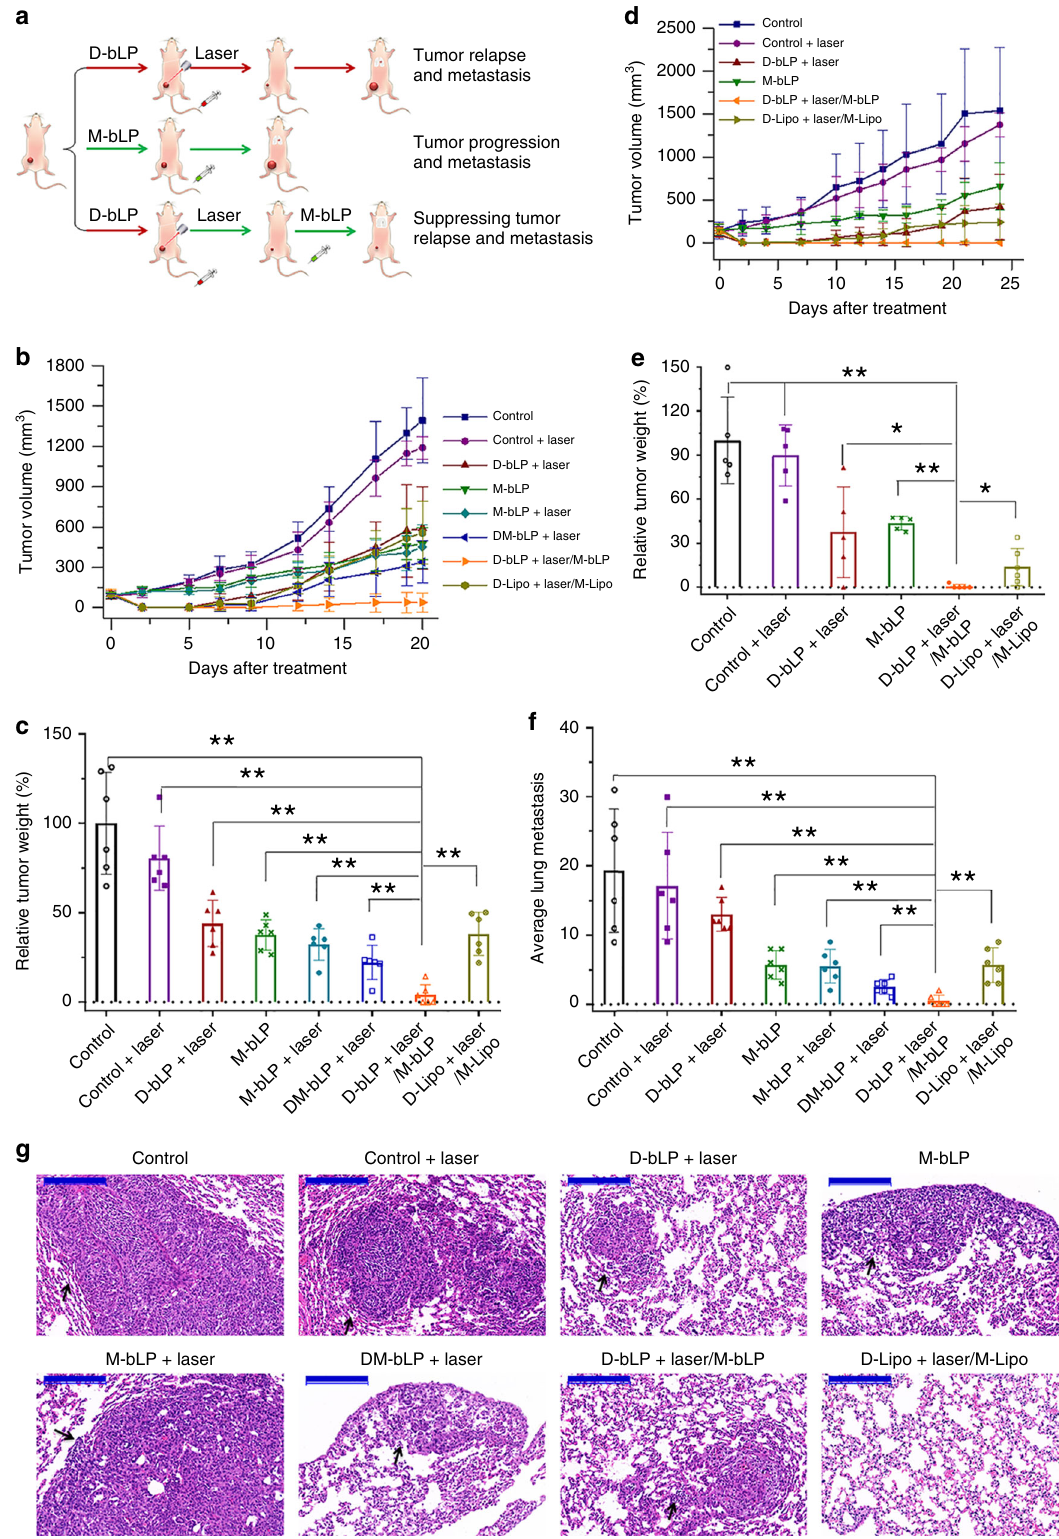
Fig. 9 The in vivo therapeutic ef fi cacy of TECA strategy on tumor relapse and metastasis in the breast cancer model. a Schematic illustration of the treatments. b The tumor growth pro fi les from each group in 4T1-induced tumor model ( n = 6). c The relative tumor weight from each group in the 4T1- induced tumor model ( n = 6). d The tumor growth pro fi les from each group in the MCF-7-induced tumor model ( n = 5). e The relative tumor weight from each group in the MCF-7-induced tumor model ( n = 5). f The average number of lung metastatic nodules from each group in the 4T1-induced metastatic model ( n = 6). g Histological examination of lung tissues from each group in the 4T1-induced metastatic model. Black arrows, metastatic lesion in lungs, scale bar, 200 µ m. The data are means ± SD, * p < 0.05, ** p < 0.01 (ANOVA and two-tailed Student ’ s t